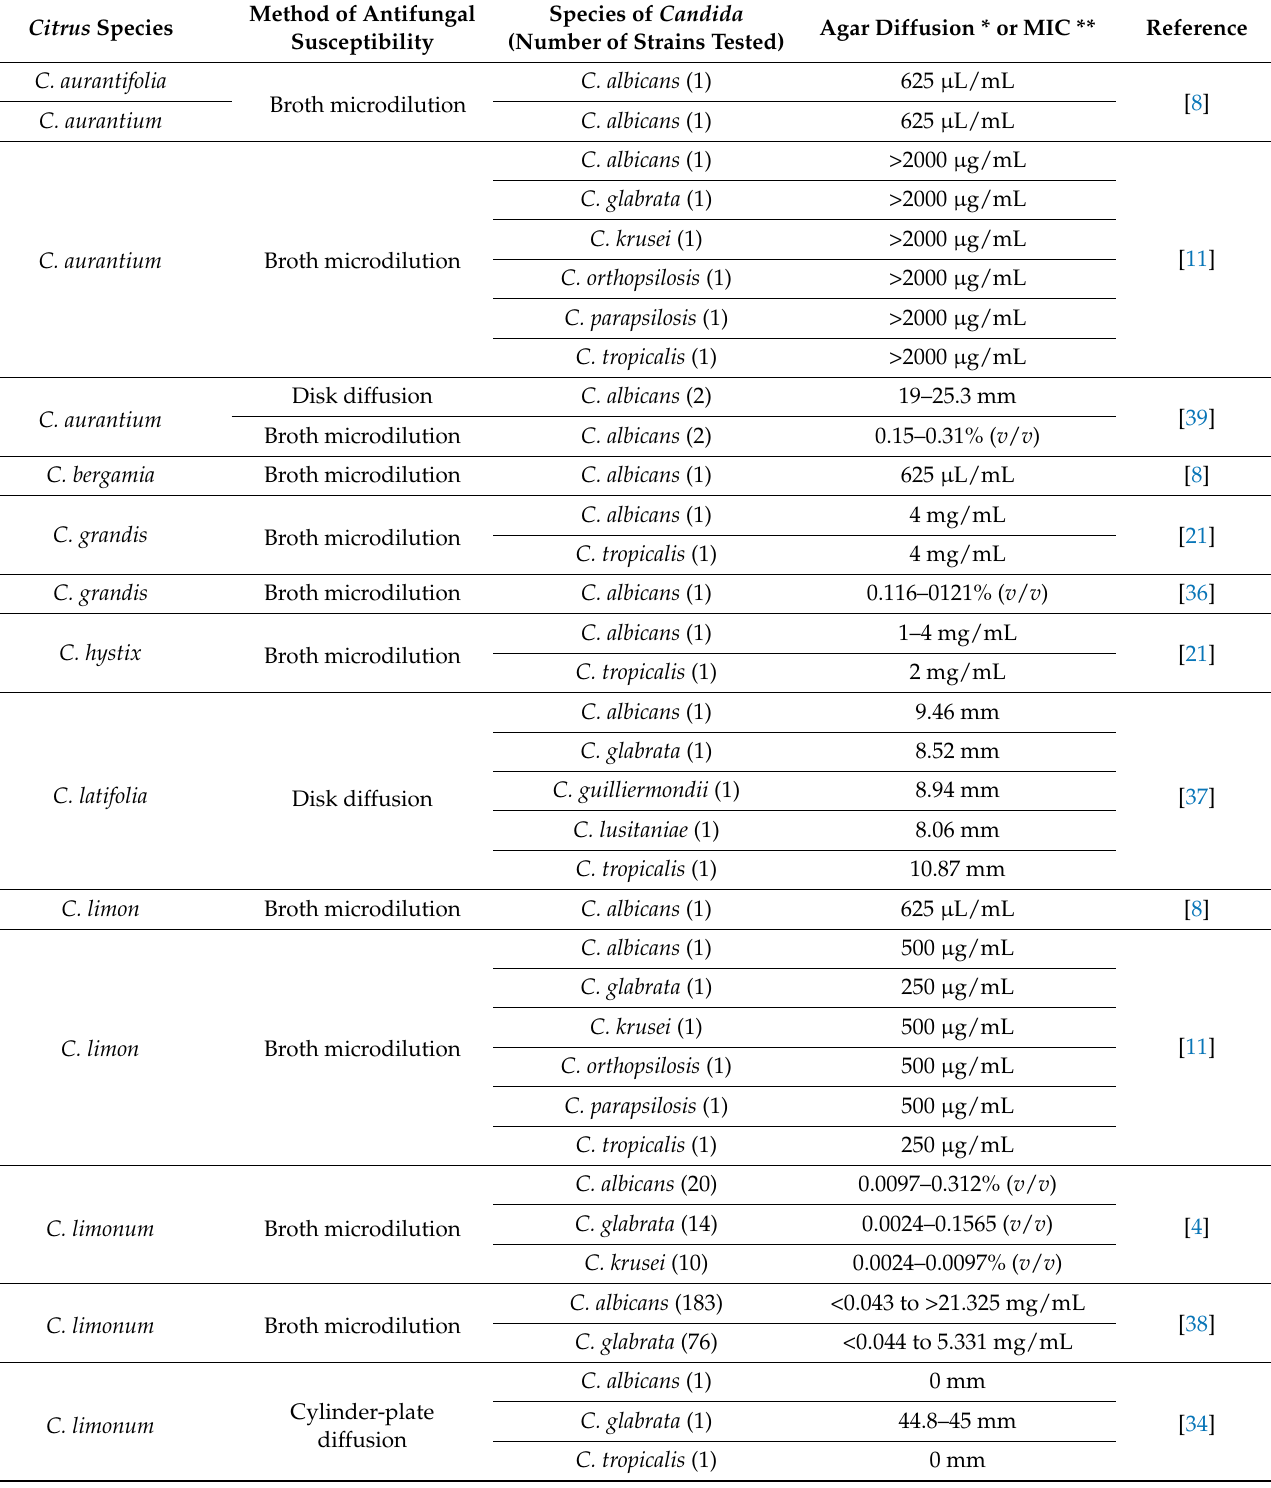
Table 2. In vitro antifungal activities of Citrus spp. essential oils tested against Candida species according to different